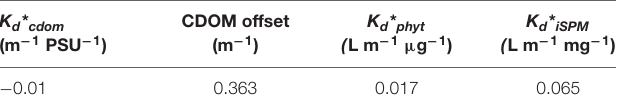
TABLE 3 | Summary of the substance-specific diffuse attenuation coefficients ( K d *) for different OAS in the monomodal